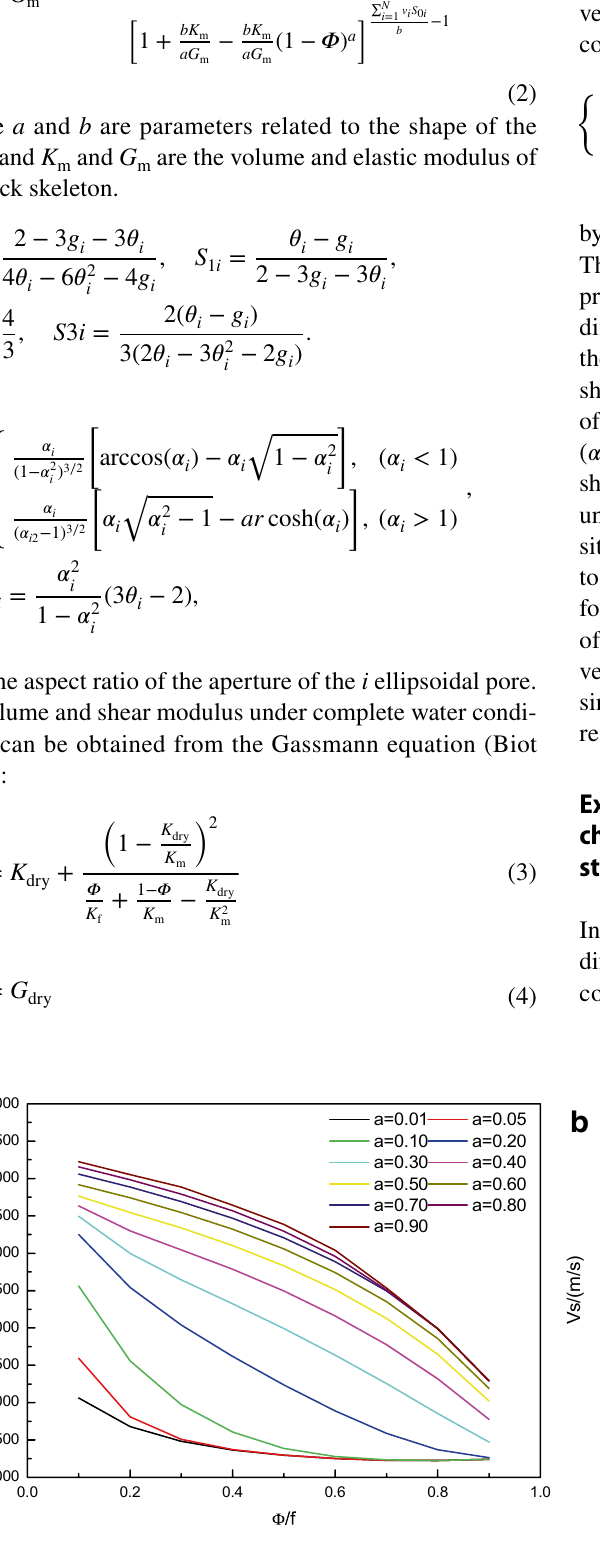
Fig. 2 a Theoretical relationship between V